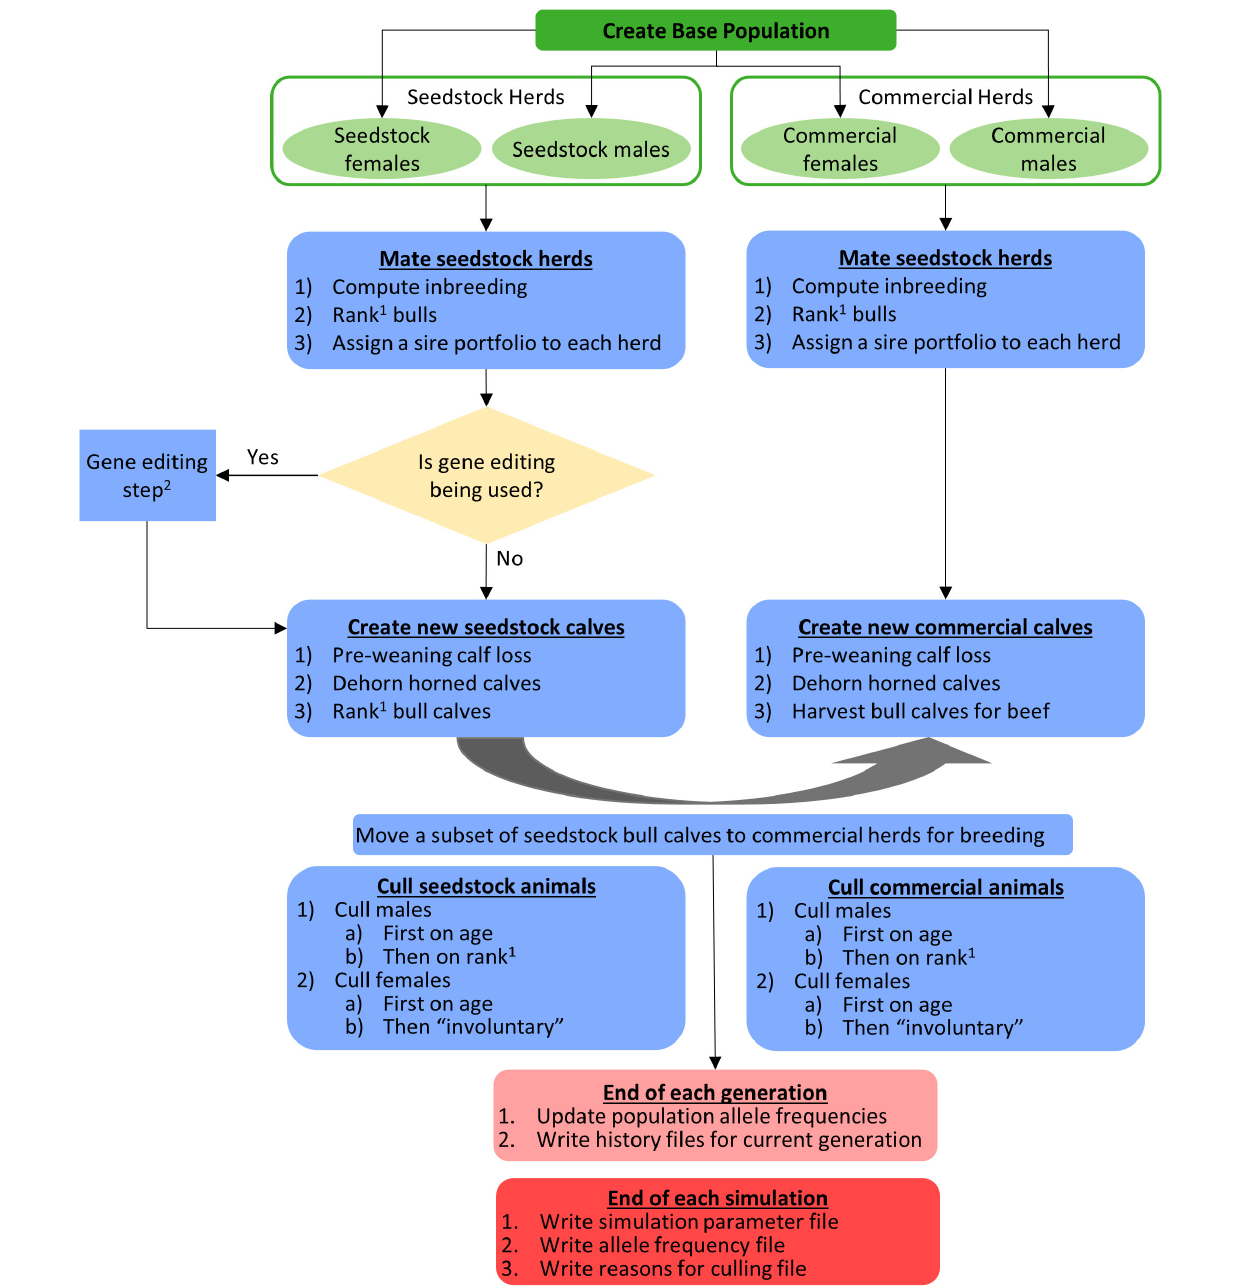
FIGURE 2 | Schematic of the flow of operations in the simulation. 1 The order of bull ranking was based on true breeding values (TBV) of the Japan Ox selection index ($JapOx) and, depending on the mating scheme used, also by polled genotype. 2 See Figures 1 , 3 for a detailed gene editing model and flowchart, respectively.